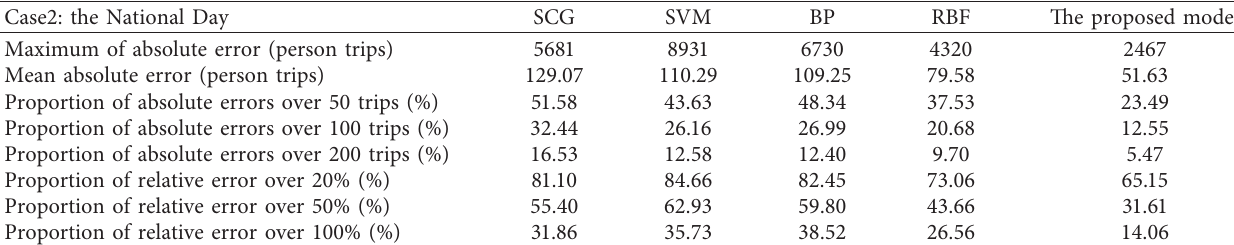
Figure 7: Scatter plot of predicted and actual value result presentation. Table 8: Statistics of model deviation in the National